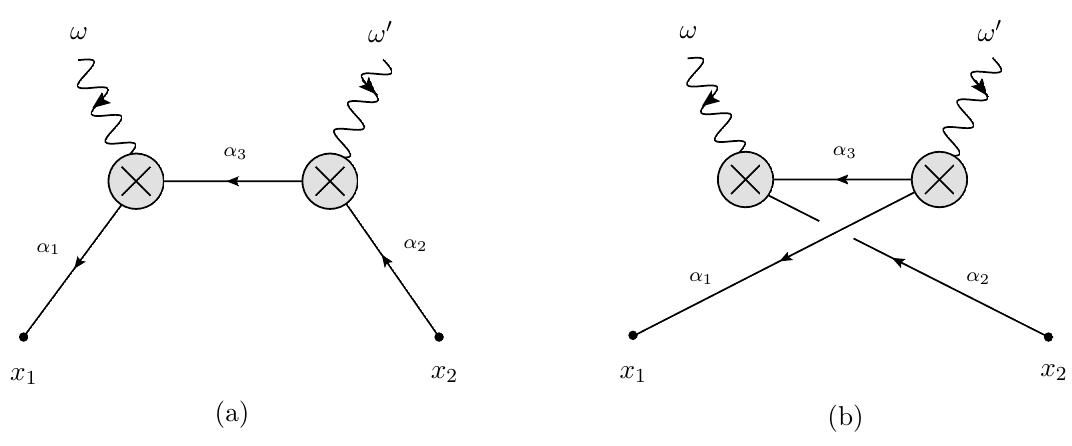
Figure 2 . Connected part of the correlation function h Φ( x 1 ) J ω,S ( n ) J ω 0 ,S 0 ( n 0 )¯Φ( x 2 ) i